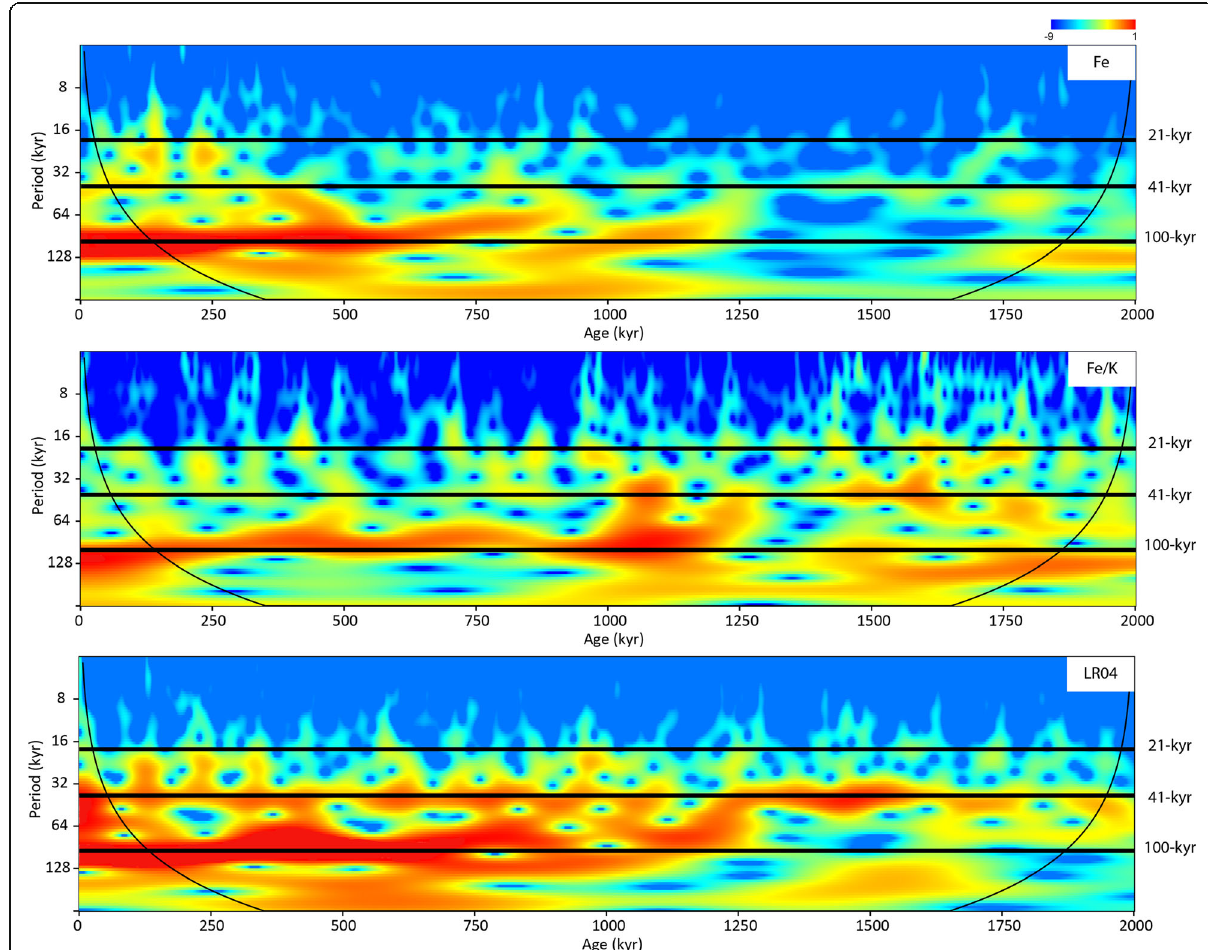
Fig. 11 Wavelet transform results of the Fe intensity, Fe/K time series and LR04 benthic stable oxygen isotope stack. The 95% confidence level curve is shown